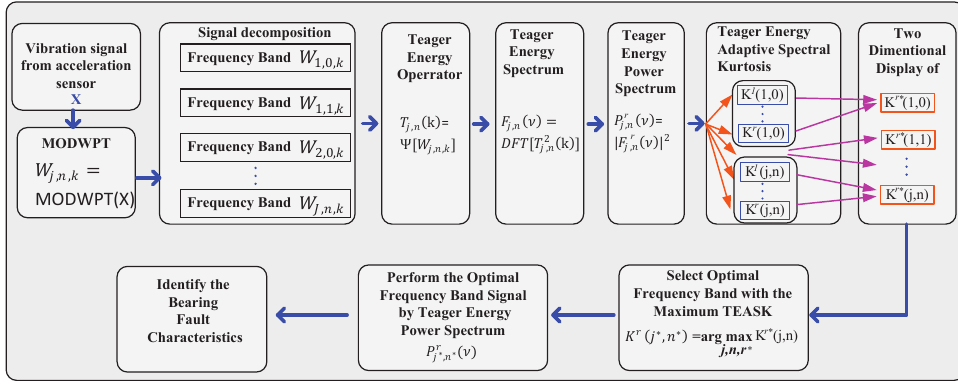
Figure 2. The flowchart of the proposed method for bearing fault detection.